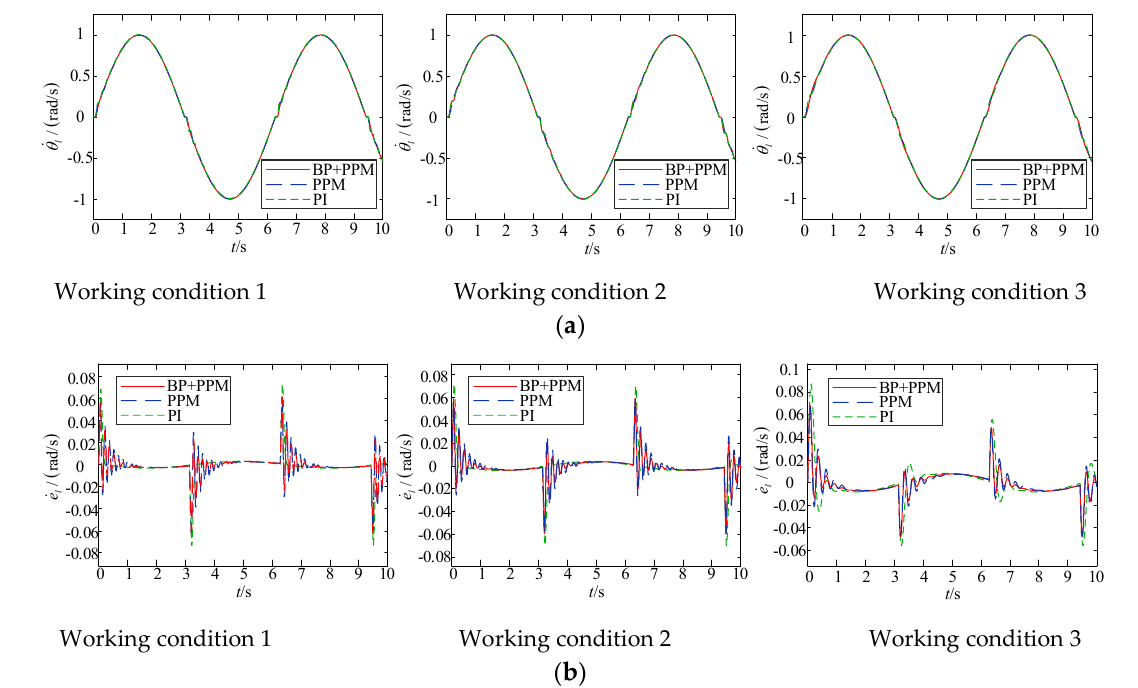
Figure 14. The load output under different control strategies. ( a ) Rotation speed at the load end. ( b ) Speed error at the load end. According to Figure 13b, taking the maximum error of PI method as the benchmark, the percentage of other methods’ maximum errors to it is